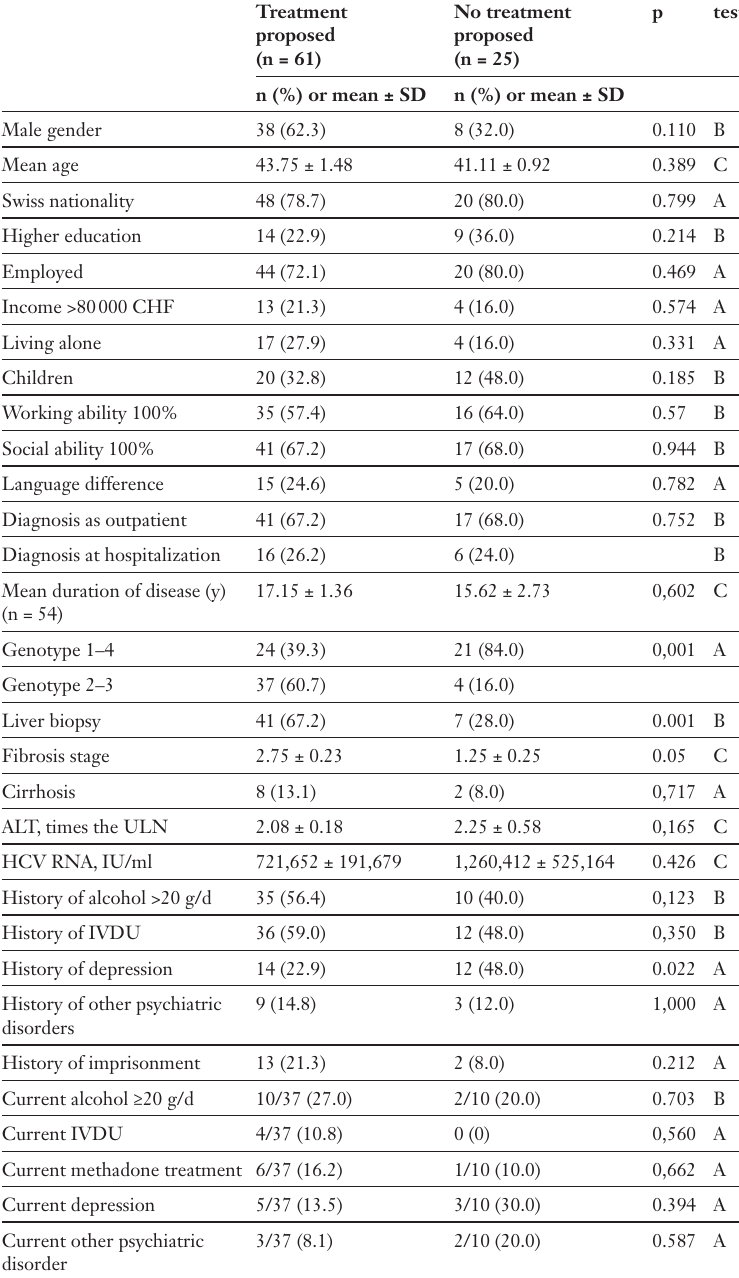
Comparison of patients according to treatment